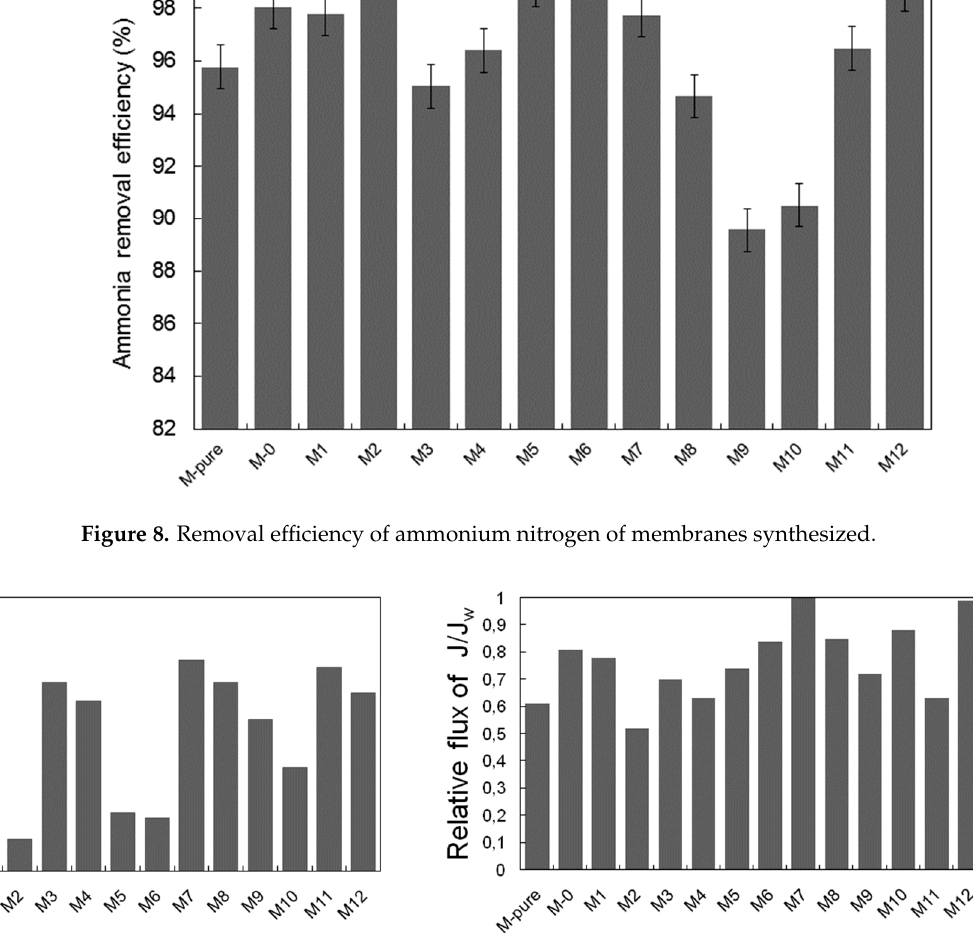
Figure 8. Removal efficiency of ammonium nitrogen of membranes synthesized.